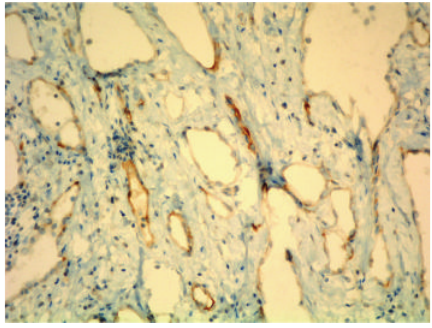
Figure 4: Calretinin positive cells surrounding